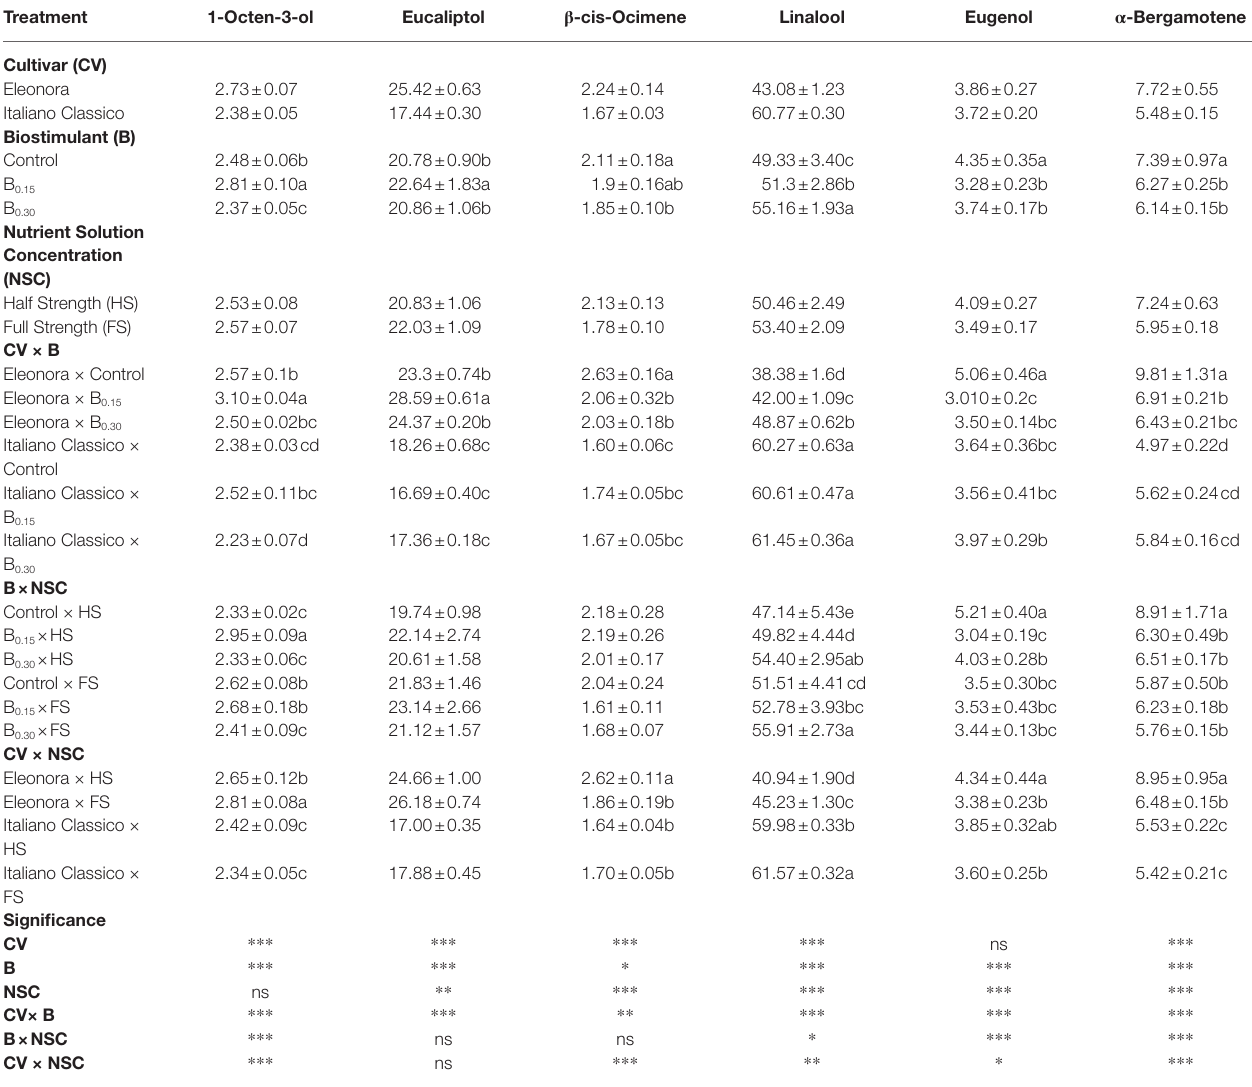
TABLE 5 | Analysis of variance and mean comparisons for volatile compounds in Eleonora and Italiano Classico genotypes grown hydroponically under two nutrient solution and dose of biostimulant.